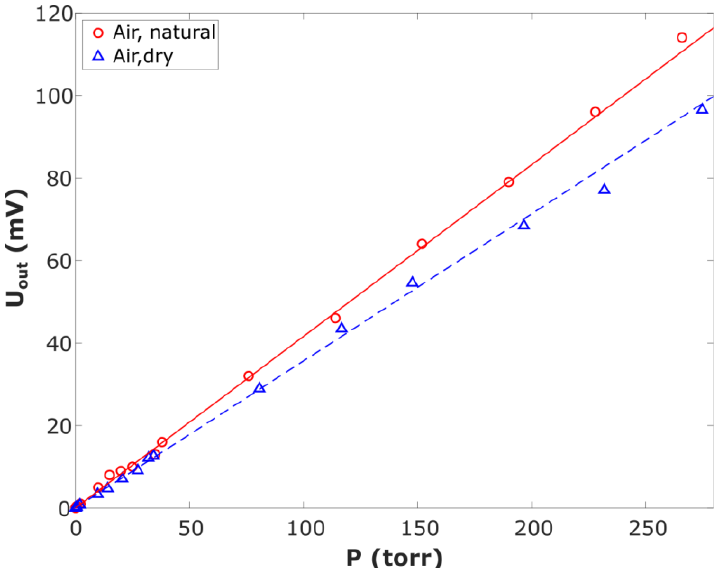
Figure 7. Output signal of the humidity sensor as a function of the air pressure: ○ is for air under natural conditions, and Δ is for dry air with a humidity of less than 1%.